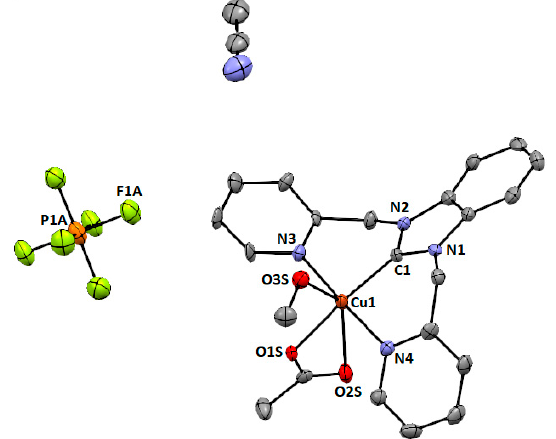
Figure 2. ORTEP representation of complex 3 . Ellipsoids are drawn at 50% probability and hydrogen atoms are removed for clarity. Selected bond lengths (Å): Cu1-C1 = 1.935(8); Cu1-N4 = 2.112(7); Cu1-N3 = 2.066(7); Cu1-O3S = 2.287(6); Cu1-O1S = 1.975(5); Cu1-O2S = 2.758. Angles ( ◦ ): N3-Cu1-N4 = 177.2(3); O1S-Cu1-C1= 162.1(3); N3-Cu1-C1 = 87.7(3); N3-Cu1-O3S = 90.9(2); N3-Cu1-O2S =